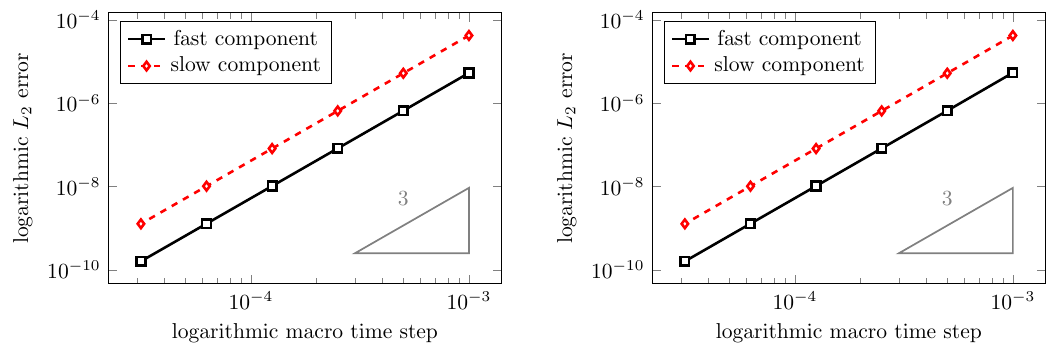
Figure 5. Experimental order of convergence. Left : Base methods IMEXRKCB3c (explicit/implicit) of third order; Right : Explicit Euler scheme for fast components, third order implicit base method of IMEXRKCB3c for slow